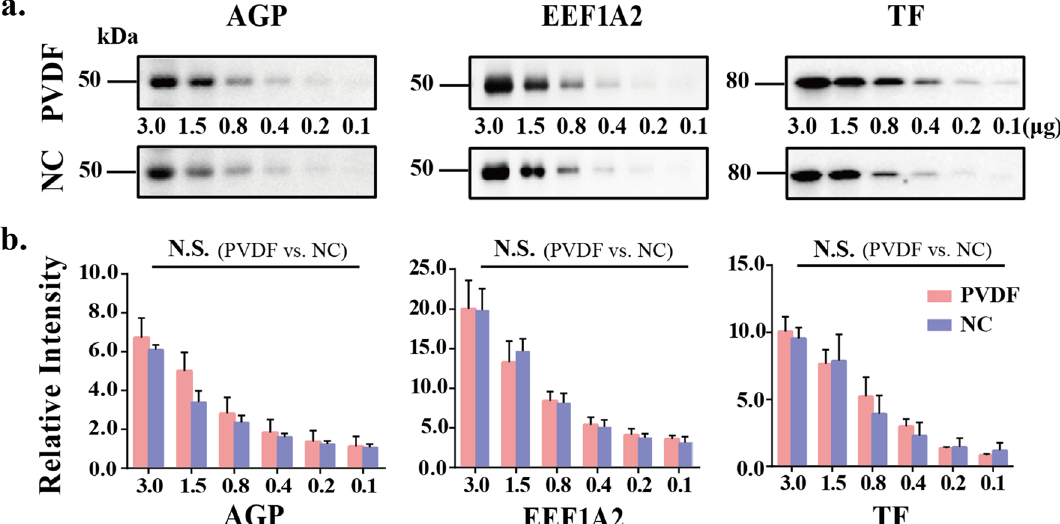
Figure 2. Comparison of the binding ability of PVDF membrane and NC membrane to medium molecular weight proteins. ( a ) The pooled sera proteins (0.1–3.0 μg) were subjected to 8% SDS-PAGE. The electroblotted membranes are PVDF membrane (up) and NC membrane (down), respectively. The membranes were incubated with anti-alpha-1-acid glycoprotein (AGP), anti-eukaryotic transformation extension factor 1 alpha 2 (EEF1A2) and anti-transferrin (TF) antibodies. ( b ) Staining intensities were statistically analyzed (n = 3 individual experiments). Pink bar, PVDF membrane; Blue bar, NC membrane. Band intensities were analyzed and compared using Image Lab software (Bio-Rad Laboratories) and GraphPad Prism version 6. N.S., not significant. All values are means ± S.E. (error